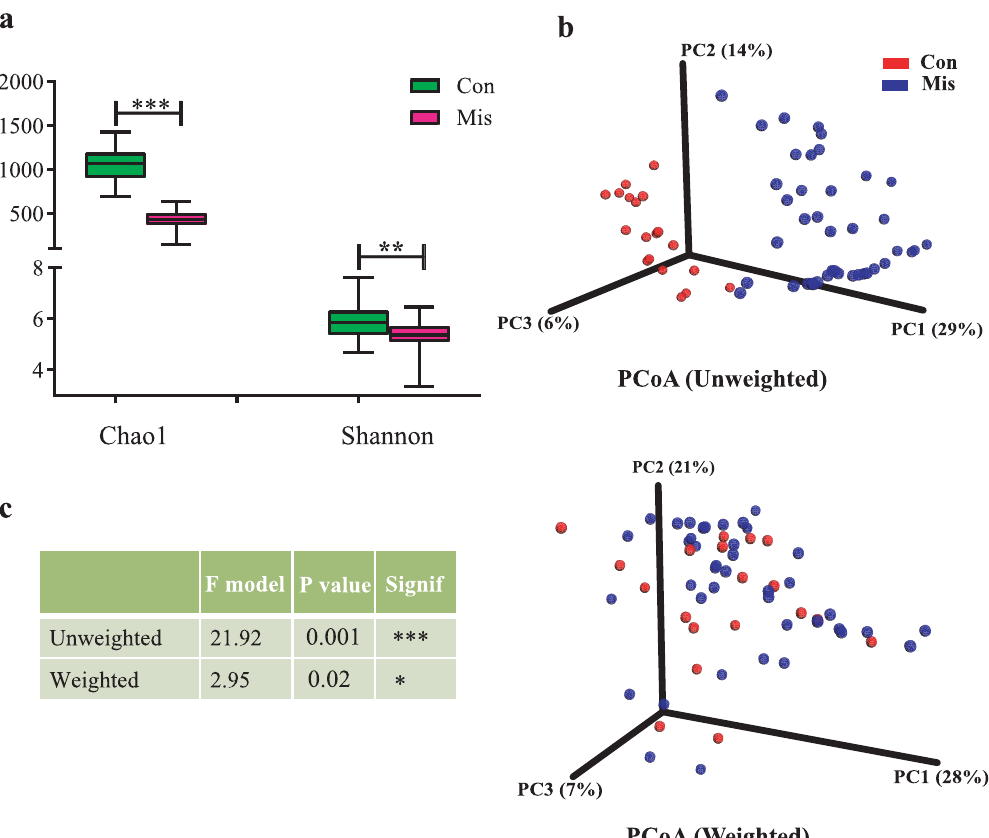
Fig. 1 Gut microbiota diversity analyses. a Species diversity differences between the miscarriage (Mis) and control (Con) groups were estimated by the Chao1, and Shannon indices. The bar are shown as mean ± SD. ** p < 0.01, *** p < 0.001. b PCoA plot base of the relative abundance of OTUs showing bacterial structural clustering. (i) Unweighted UniFrac PCoA plots; (ii) Weighted UniFrac PCoA plots. Miscarriage group (blue dots), Con group (red dots), where dots represent individual samples. c Adonis analysis of statistical summary of different groups. F Model, represents F -test value; * p < 0.05, *** p <